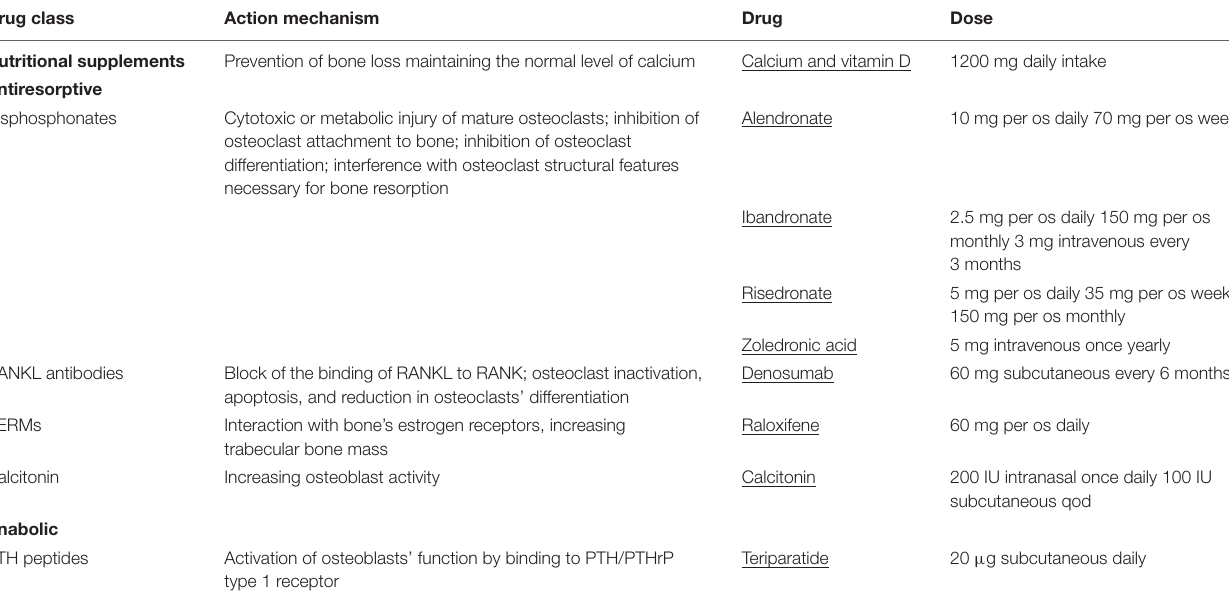
TABLE 1 | Brief classification of osteoporosis drugs, action mechanism and dosages (Camacho et al., 2016). Drug class Action mechanism Nutritional